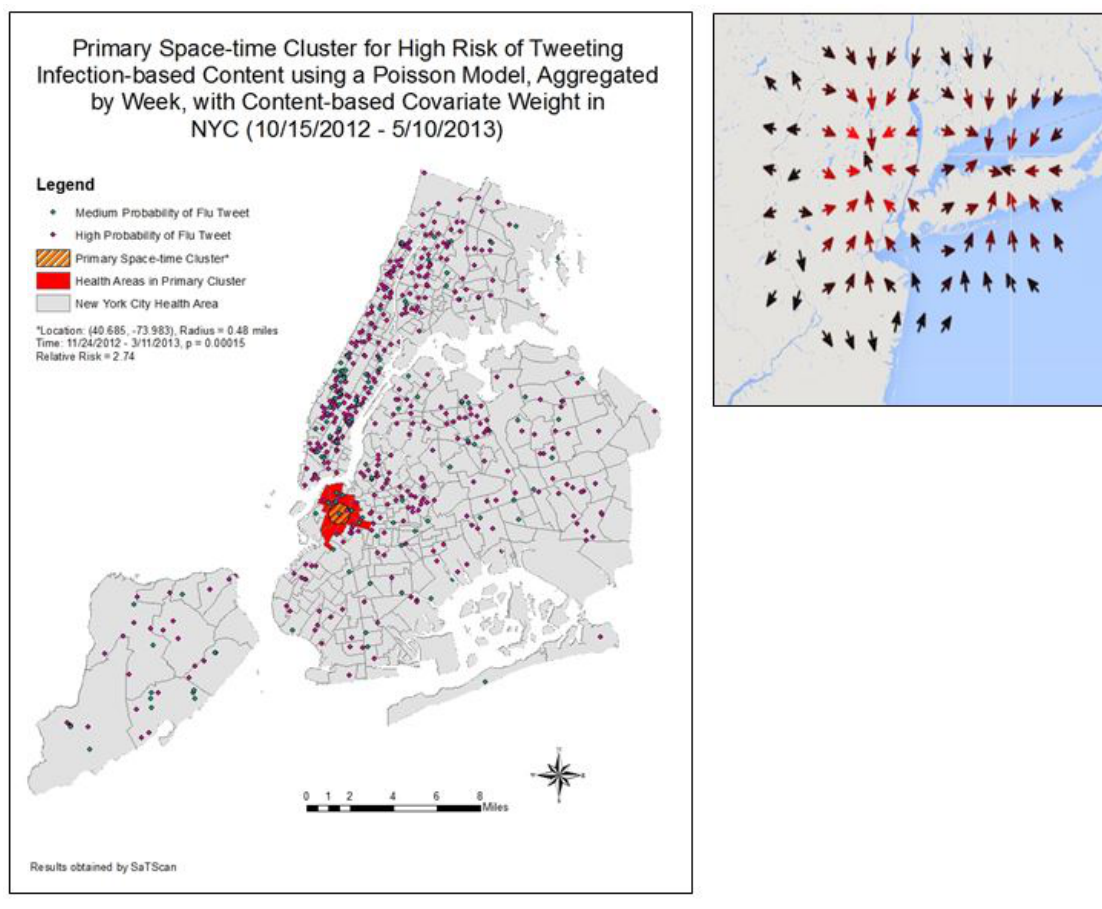
Figure 4. Right: Retrospective primary space-time cluster (p < .001) for high risk of tweeting flu infection-based Content, determined by a Poisson Model with cases as High Probability Flu Tweets and controls as Medium Probability Flu Tweets, aggregated by week, and with content-specific covariate weight in NYC during 10/15/2012-5/10/2013. Top Left: Epicenter located at (40.685, -79.983) with 0.48 mile radius including places of mass gathering such as Barclays Center and Atlantic Avenue Terminal. Bottom Left: Prospective approach to modeling weekly changes in local Infection-tweet